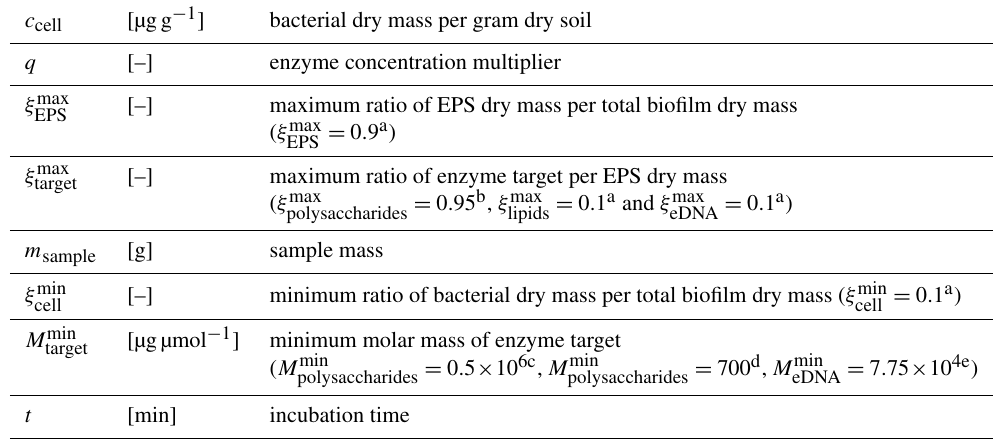
Table 2. Variables used for the calculation of enzyme units needed for biofilm target decomposition and scenario parameters shared by all variants.